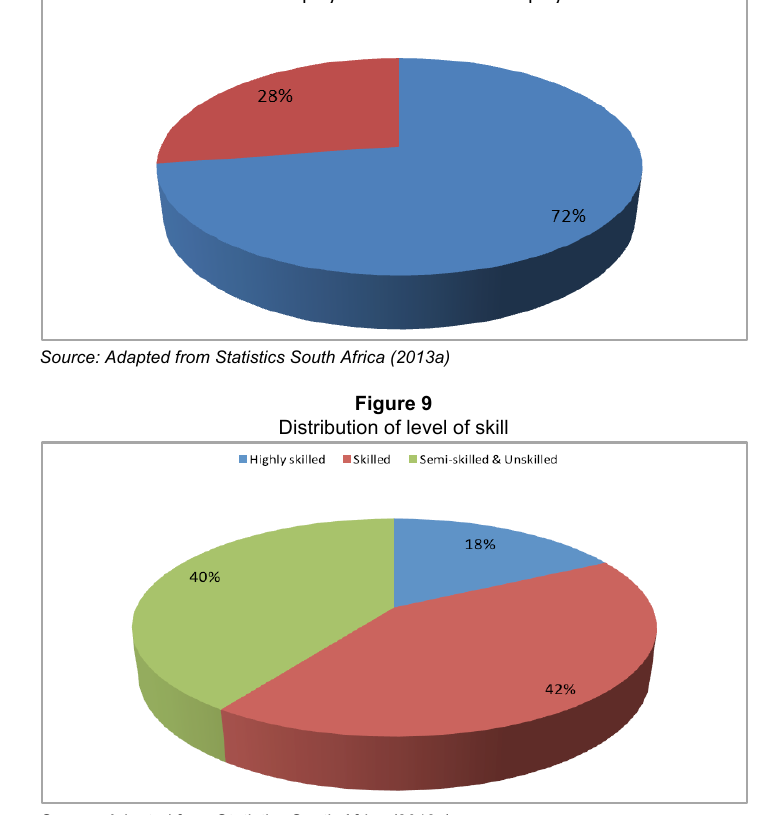
Figure 8 Distribution of formal employment vs. informal employment